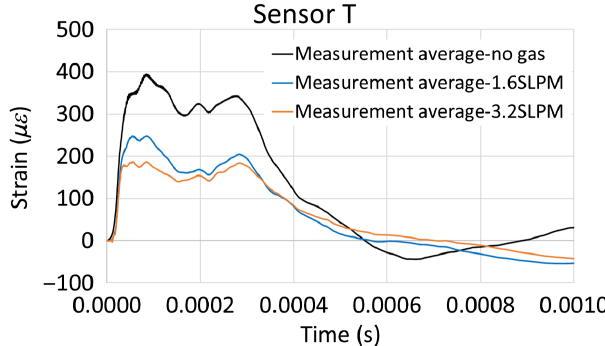
FIG. 28. Strain measurement data of sensor T without and with gas